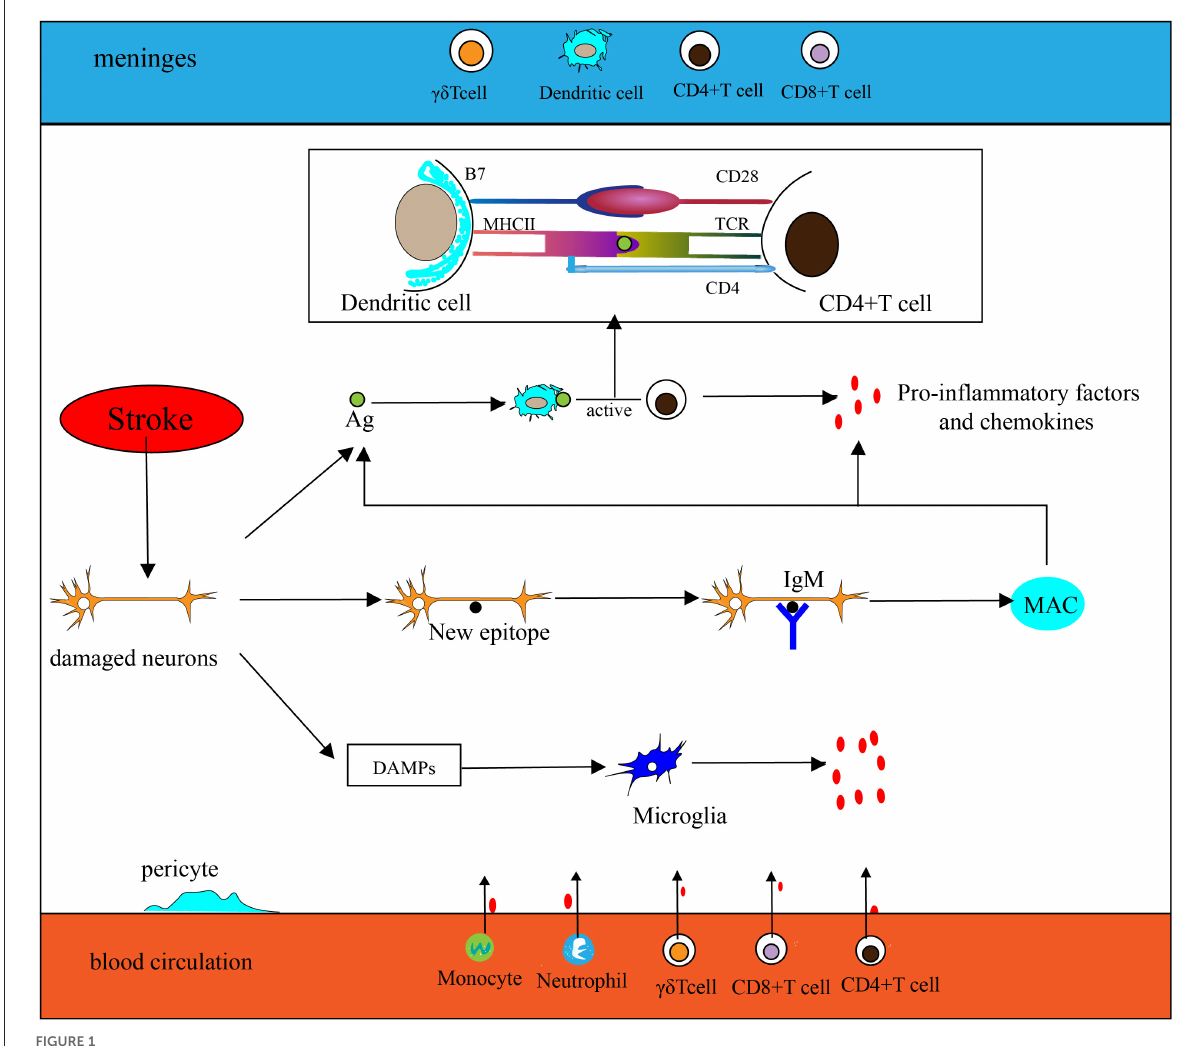
FIGURE1 Inflammation in the ischemic brain. (1) Antigen (Ag) released by damaged neurons is ingested and processed by dendritic cells (DCs), then stimulates T cell activation (take CD4 + T cells as an example, CD4T cells are activated by MHC II–peptide–TCR and CD28-B7). Activated T cells secrete pro-inflammatory factors and chemokines to participate in the inflammatory response. (2) Neurons are exposed to new epitopes after necrosis, which can be recognized by natural immunoglobulin IgM in brain tissue, thereby activating the classical pathway of the complement system and forming a membrane attack complex (MAC) eventually. Then cellular contents are released extracellularly by MAC, which exacerbates the inflammatory response. (3) Injured neurons release DAMPs to activate microglia and participate in the inflammatory response. (4) Chemokines secreted by microglia and other inflammatory cells promote peripheral phagocytes, neutrophils, CD4 + T cells, CD8 + T cells, and γδ T cells to migrate toward CNS.